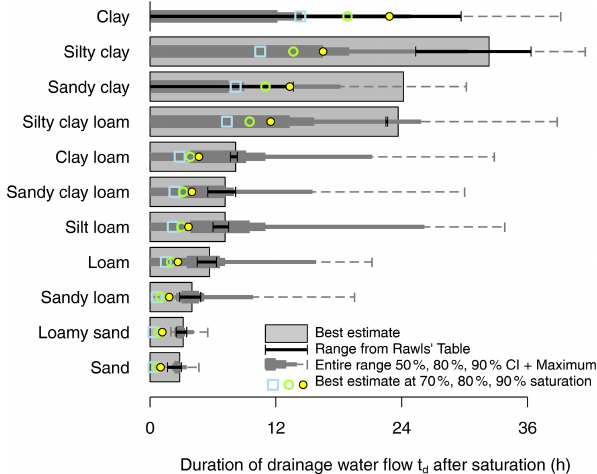
Figure F1. Estimated duration of percolation ( t d ) at the bottom of a 25cm soil monolith in a ML for various soil types. Bars show the best estimate for each soil type for completely saturated soils, and whiskers show the range that results when the parameter range given by Rawls et al. (1991) in Table F1 is used. Symbols show the reduced t d when the average water content of the soil monolith is 90% of its saturation (yellow circles), 80% (green circles), or 70% (blueish circles). Because the system is highly non-linear, the pa- rameters given in Table F1 do not result in the full range of t d , and hence we added the maximum that can be obtained with intermedi- ate model parameters for each soil type (dashed whiskers) and the 70%, 80%, and 90% two-sided confidence intervals (grey bars of varying width; see legend) for all t d resulting from combinations of parameter values within the bandwidth given in Table